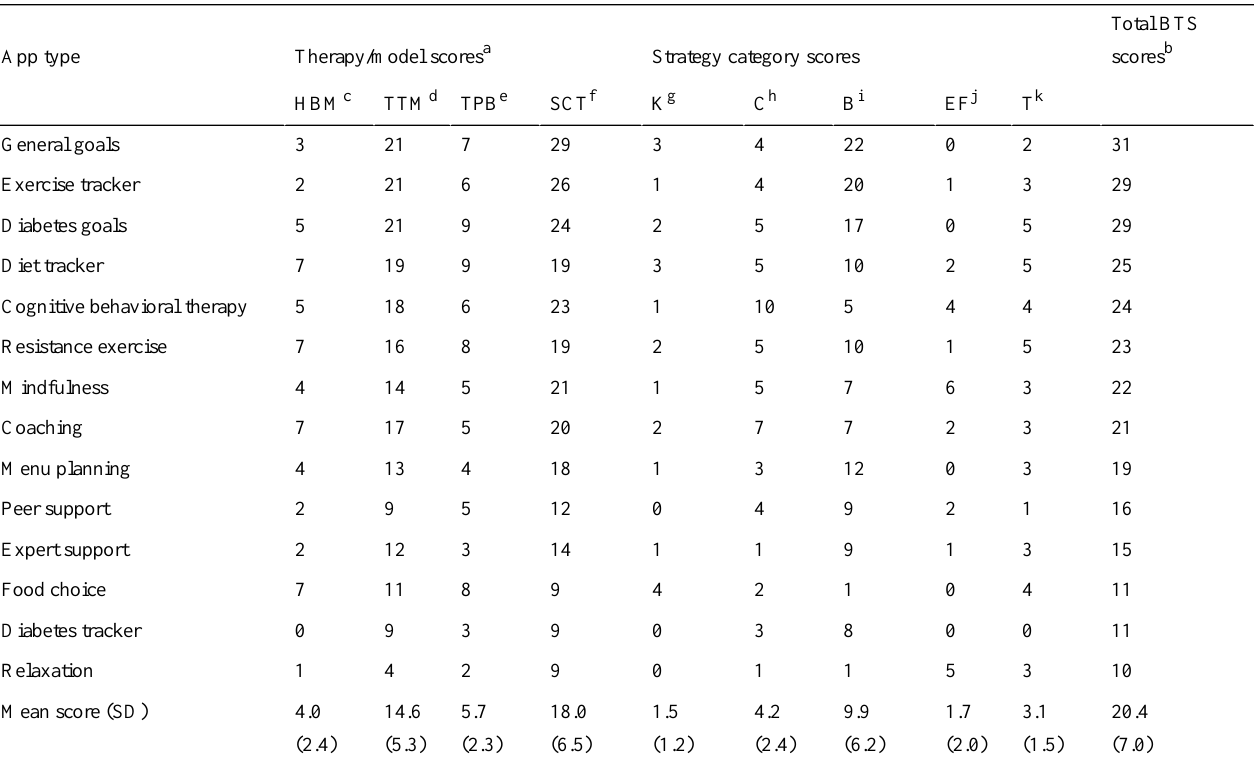
Table 3. Total Behavioral Theory Survey score and individual component scores of those apps scoring best in type.